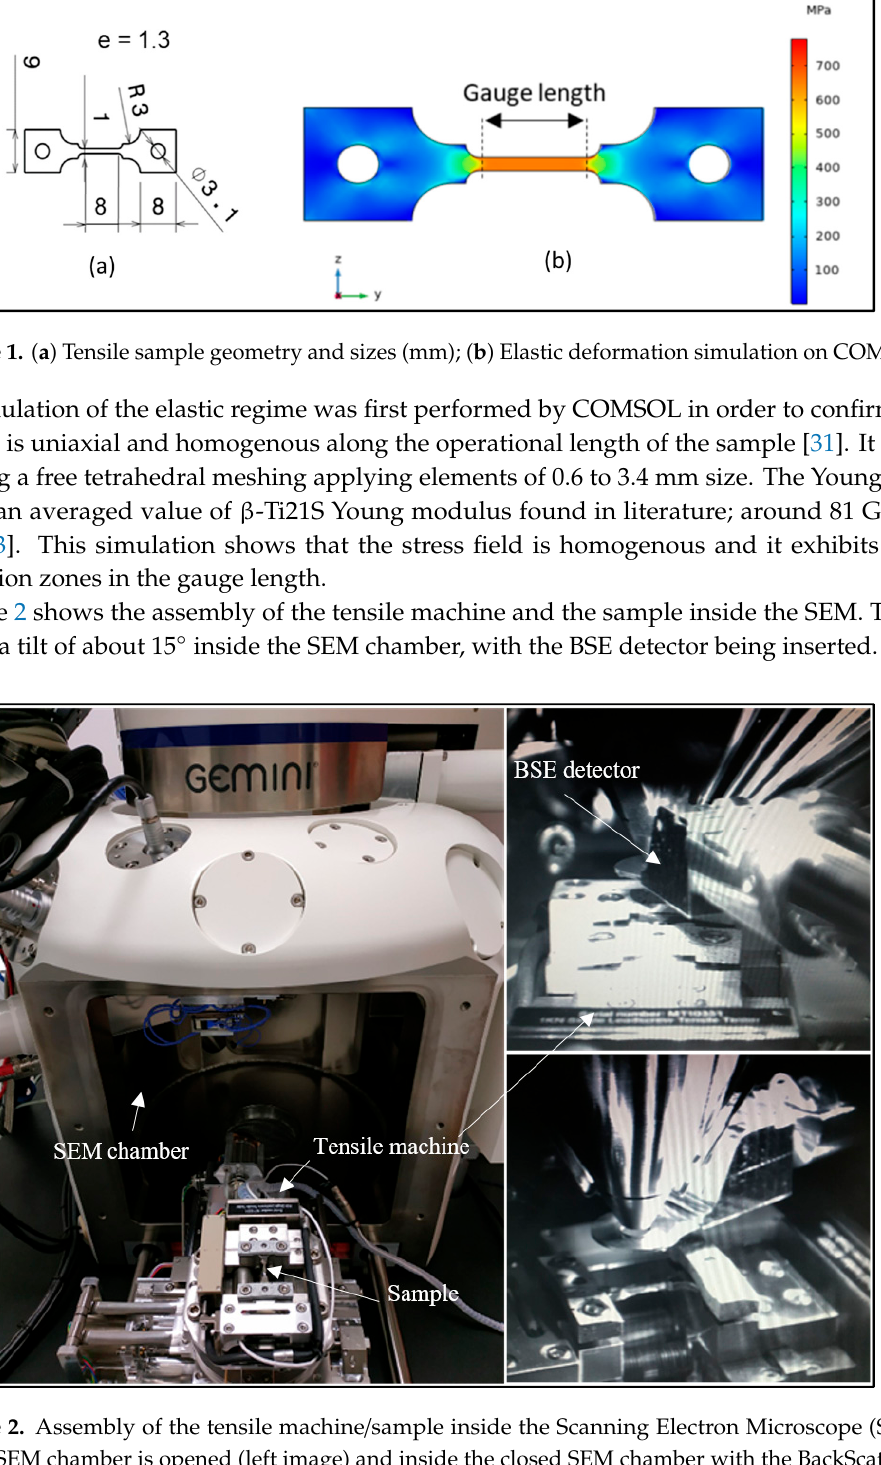
Figure 2. Assembly of the tensile machine/sample inside the Scanning Electron Microscope (SEM); when SEM chamber is opened (left image) and inside the closed SEM chamber with the BackScattered Electrons (BSE) detector inserted (right images).